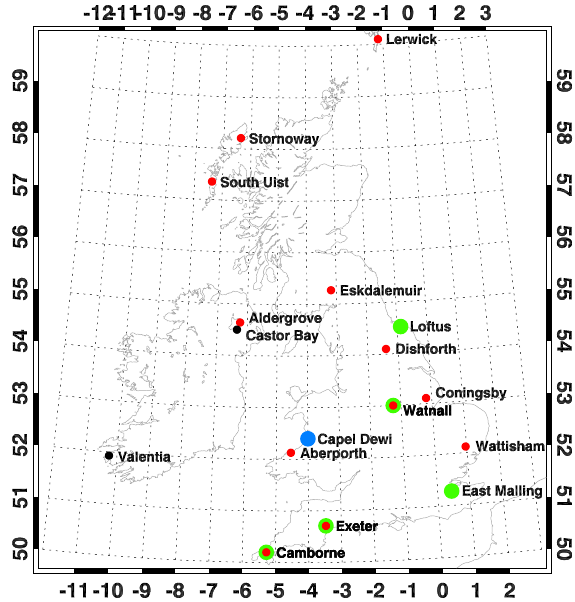
Figure 1. Location of lidar stations used in this paper. Blue and green circles denote Raman lidars, red denotes Lufft CHM 15k ceilometers and black denotes the two radiosonde stations men- tioned in the text Table 1. Data coverage from Met Office lidars. I denotes